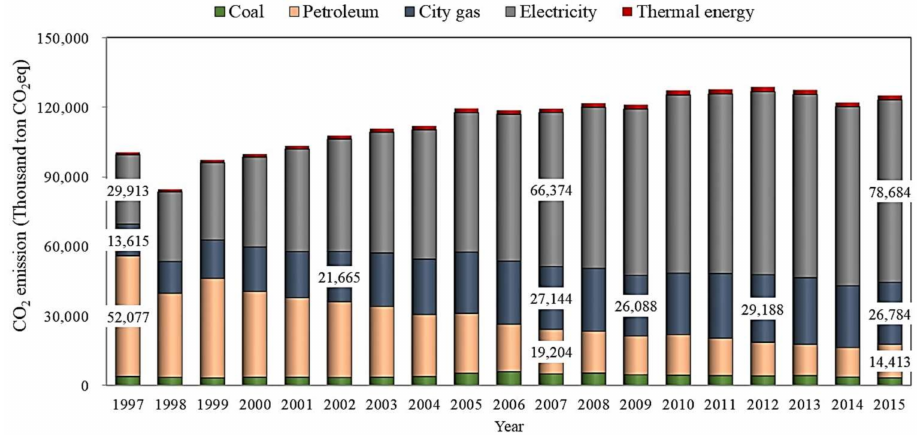
Figure 8. Greenhouse gas emission in buildings by energy